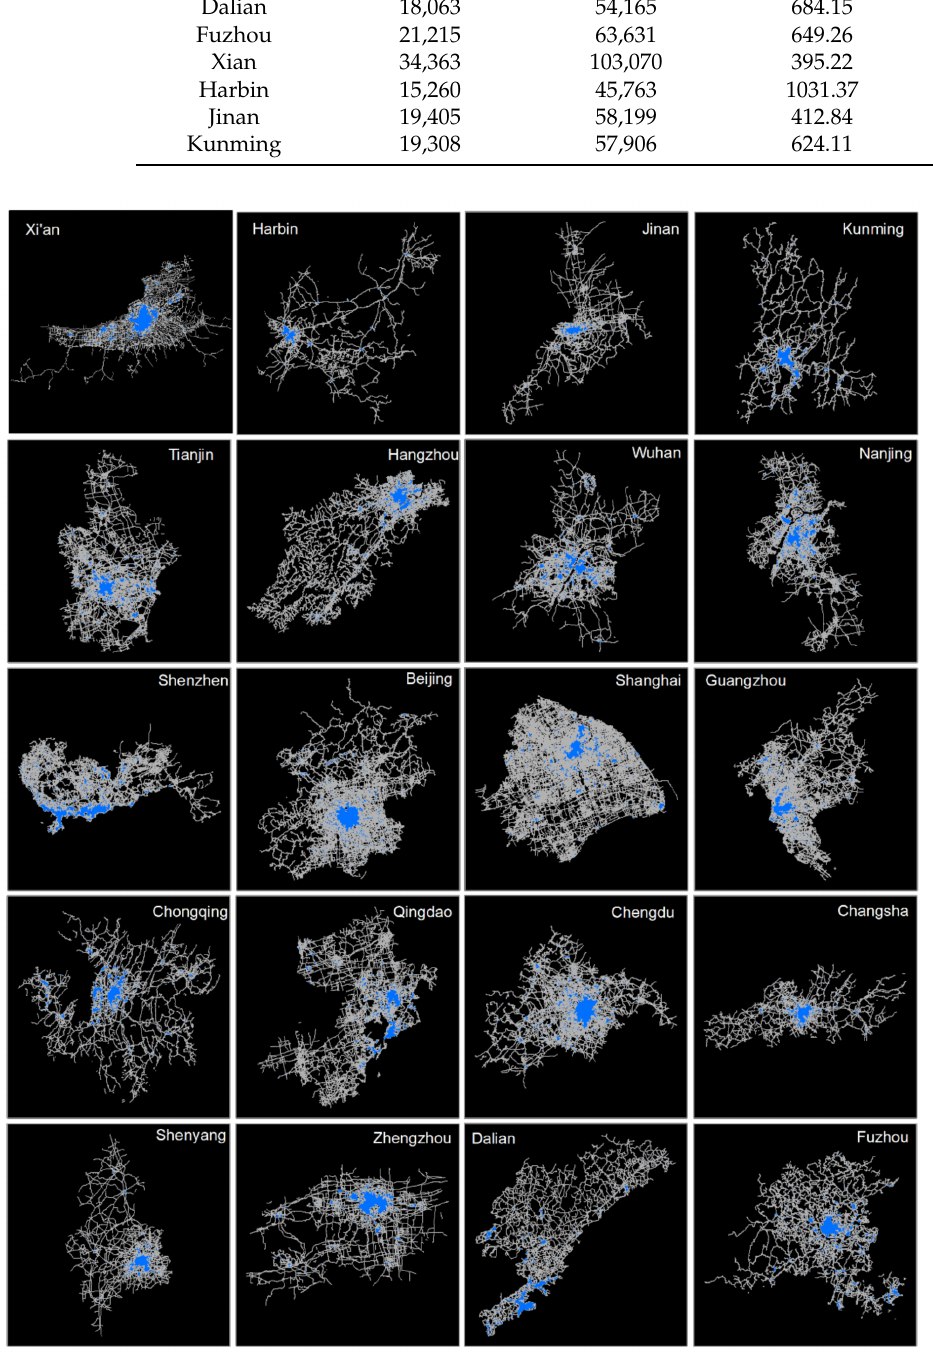
Figure 3. (Color online) Urban hotspots based on the density of street junctions throughout the top 20 Chinese